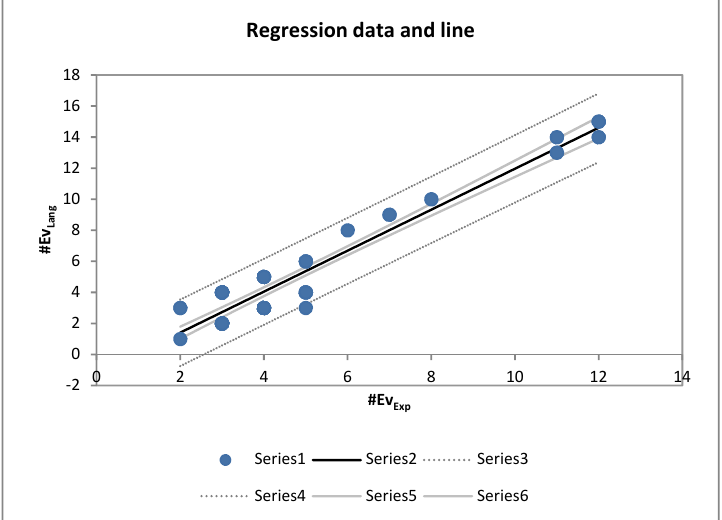
and Ev Exp Lang